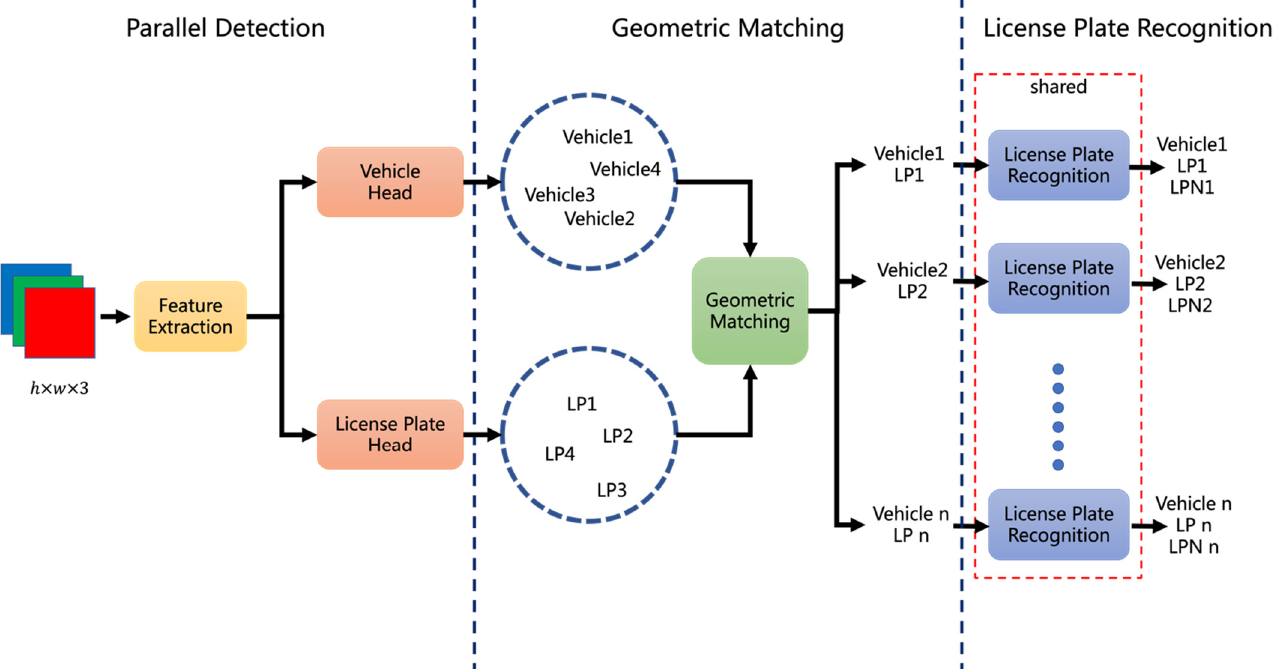
Figure 4. The structure of the proposed PDM.